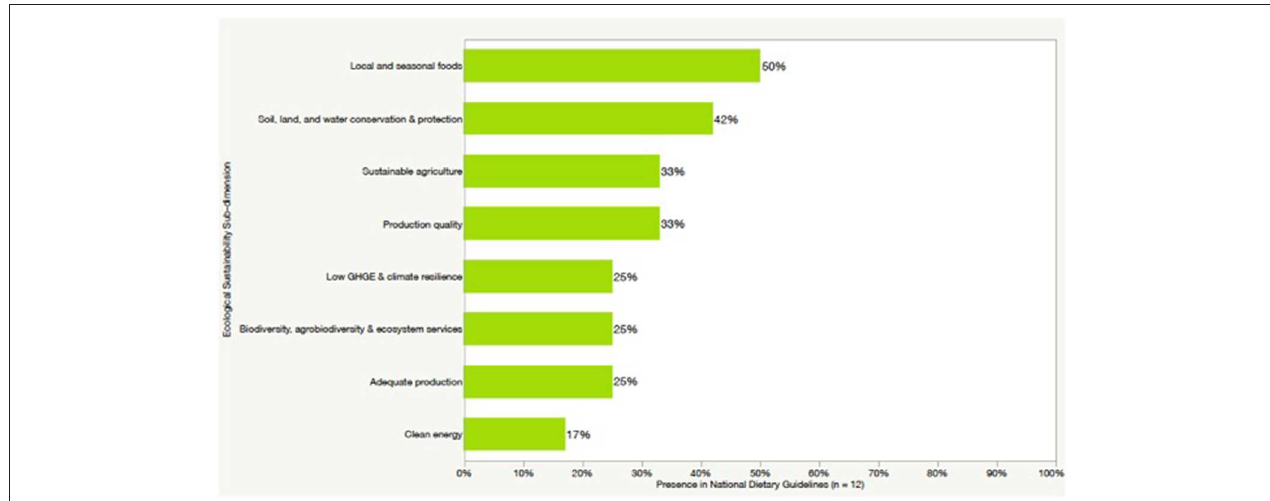
FIGURE 2 | Presence of ecological sub-dimensions in national dietary guidelines. This figure demonstrates the presence of the eight sub-dimensions of ecological sustainability in the 12 national dietary guidelines evaluated in this